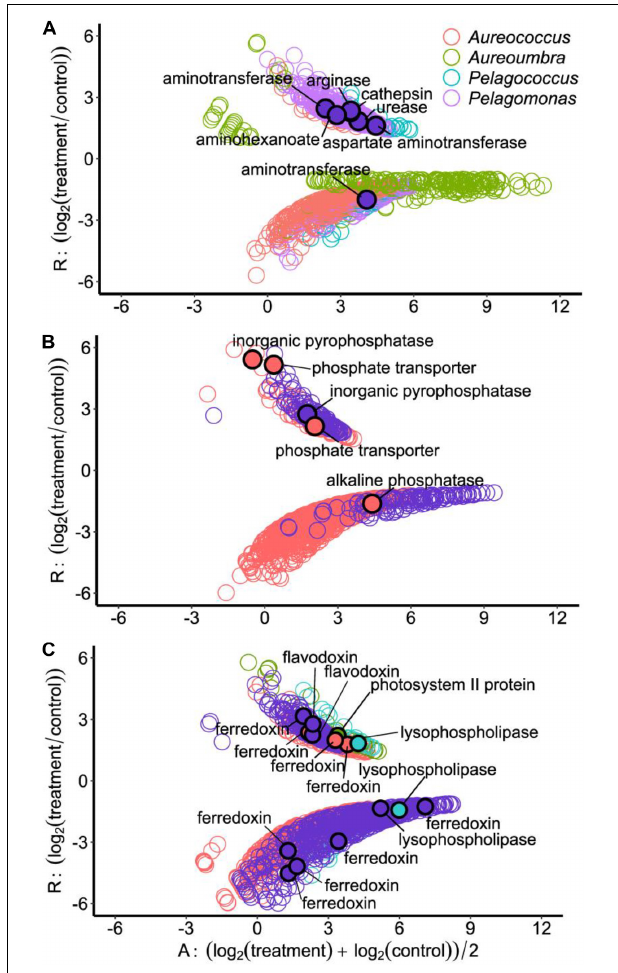
FIGURE 6 | Ratio-Average (RA) plots of OGs among four pelagophytes in response to different treatments: (A) Low N, (B) Low P, and (C) Low light treatment. Each circle represents a differentially abundant OG and filled circles with black border represent differentially abundant OGs that are described in the